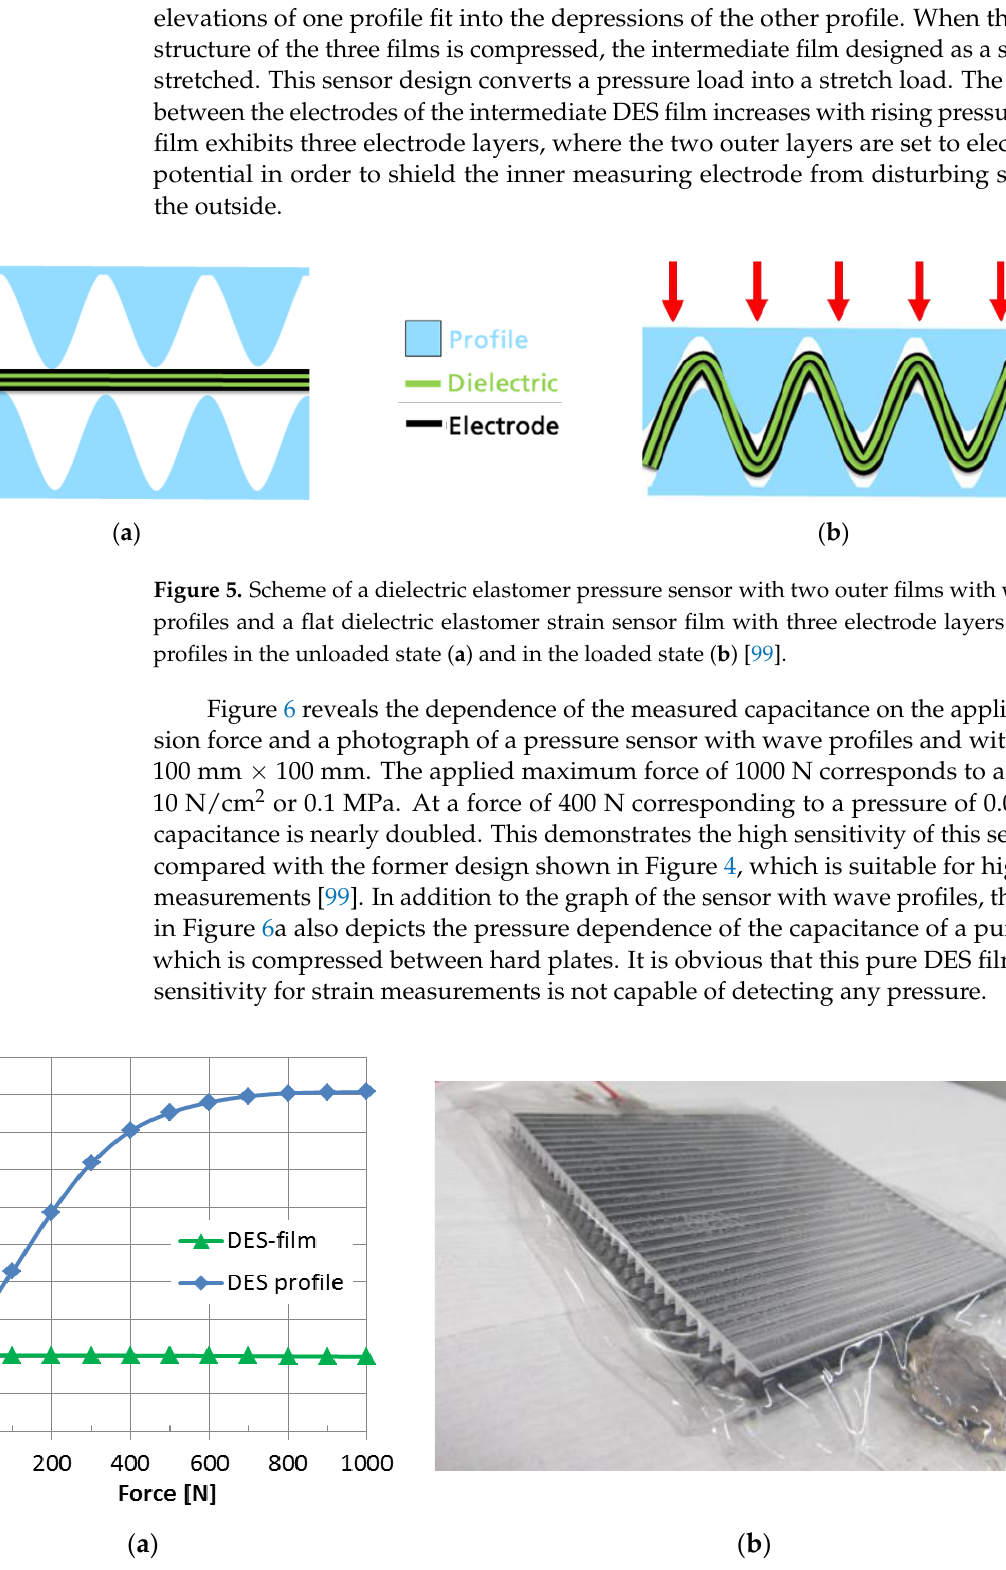
( c ) Figure 4. Scheme of the bulging of a dielectric elastomer pressure sensor with soft plates with open- ings ( a ), photograph of the pressure sensor ( b ) and measured capacitance upon increase and de- crease in pressure in two cycles ( c ) [97]. The pressure sensor mechanism shown in Figure 4 is suitable for the measurement of relatively high pressure in the order of magnitude of 1 MPa. These sensors could be used for load monitoring in high-pressure applications such as bridge mounts, engine mounts and other elastomer dampers. A strong enhancement of the sensitivity of dielectric elastomer pressure sensors is obtained with a sensor design that contains voids or pores in the elastomer structure. This